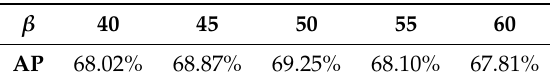
Table 1. AP on KITTI validation set using different β